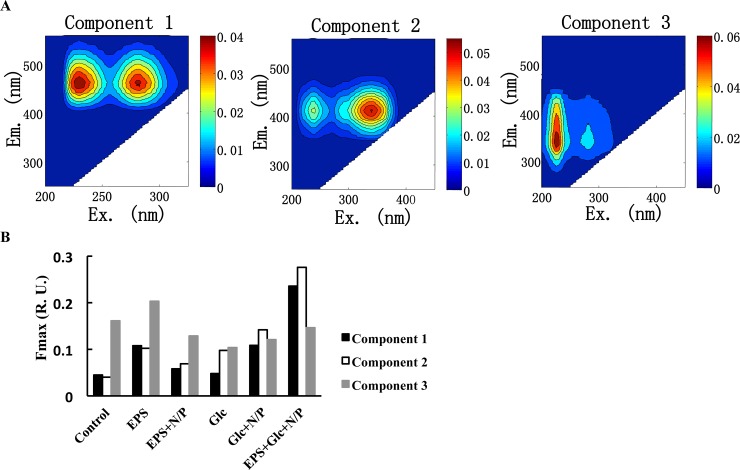
Three fluorescence components identified by the PARAFAC model.(A) Fluorescence graphs of the three components (component 1–3). (B) Fluorescence intensities of the three components after cultivation of seawater for 14 days.